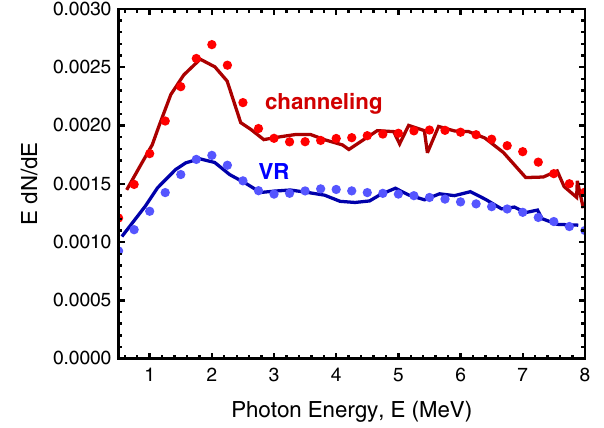
FIG. 4. Simulated (points) and experimental (lines) radiation spectra of 855 MeV electrons in Si bent crystal 30 . 5 μ m thick with 33.5 mm bending radius for crystal-to-beam perfect align- ment 0 μ rad (channeling) and at 493 μ rad (volume reflection). The beam angular divergence is 30 μ rad.